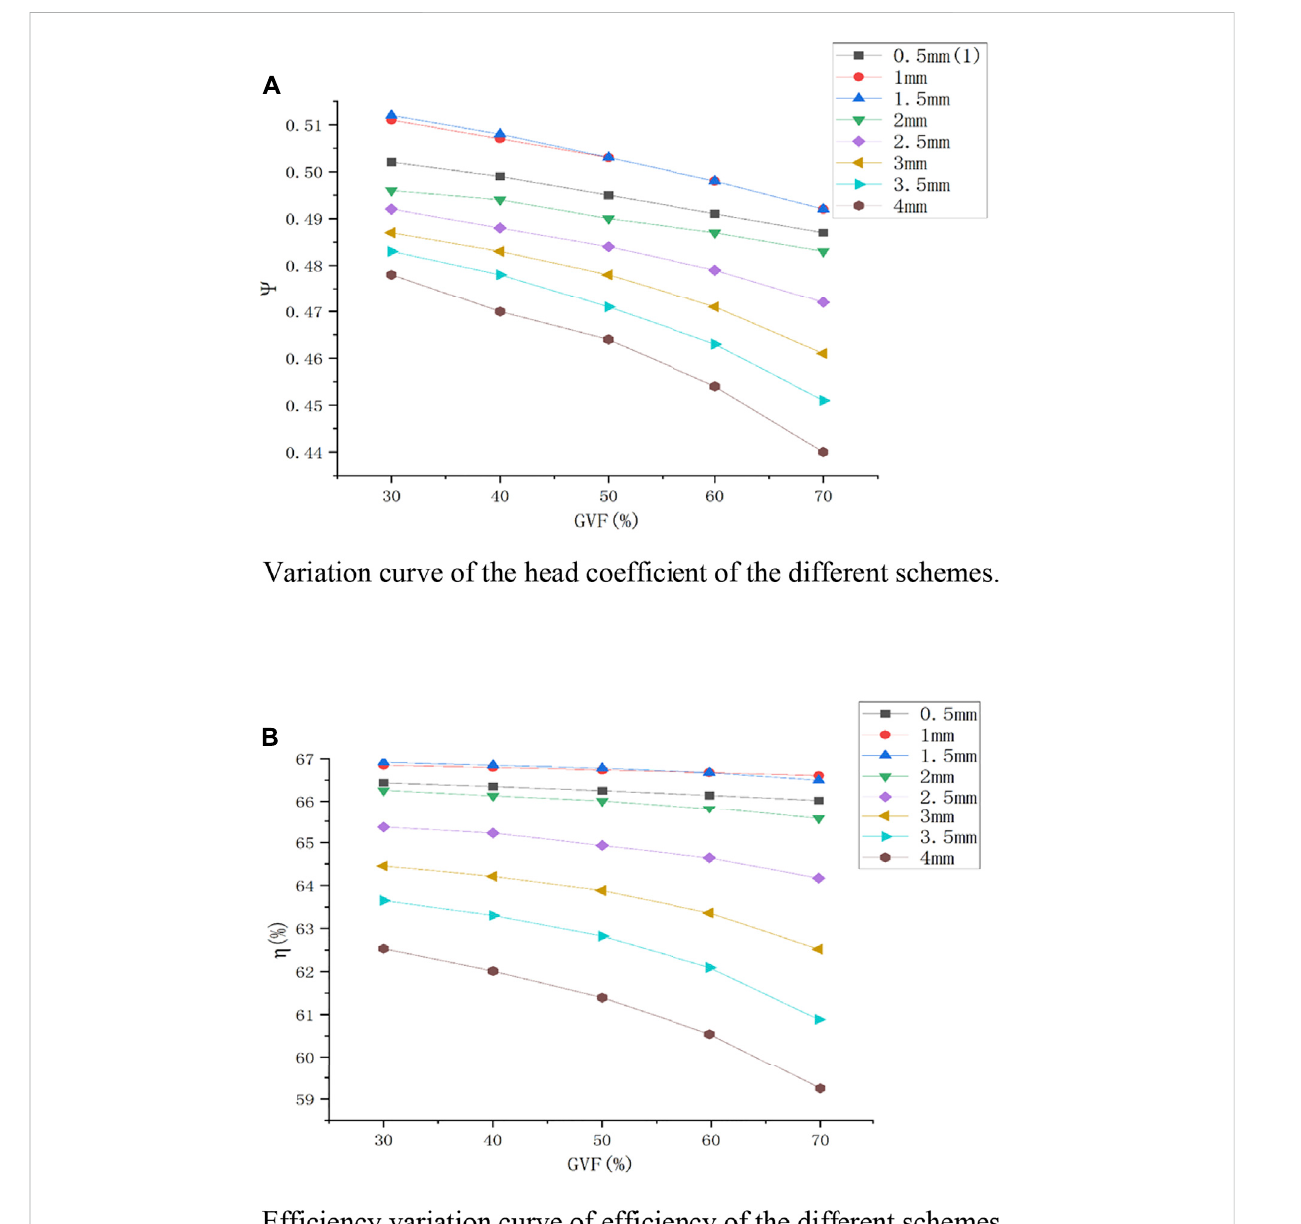
FIGURE 7 Ψ and η curves. (A) Variation curve of the head coef fi cient of the different schemes. (B) Ef fi ciency variation curve of ef fi ciency of the different